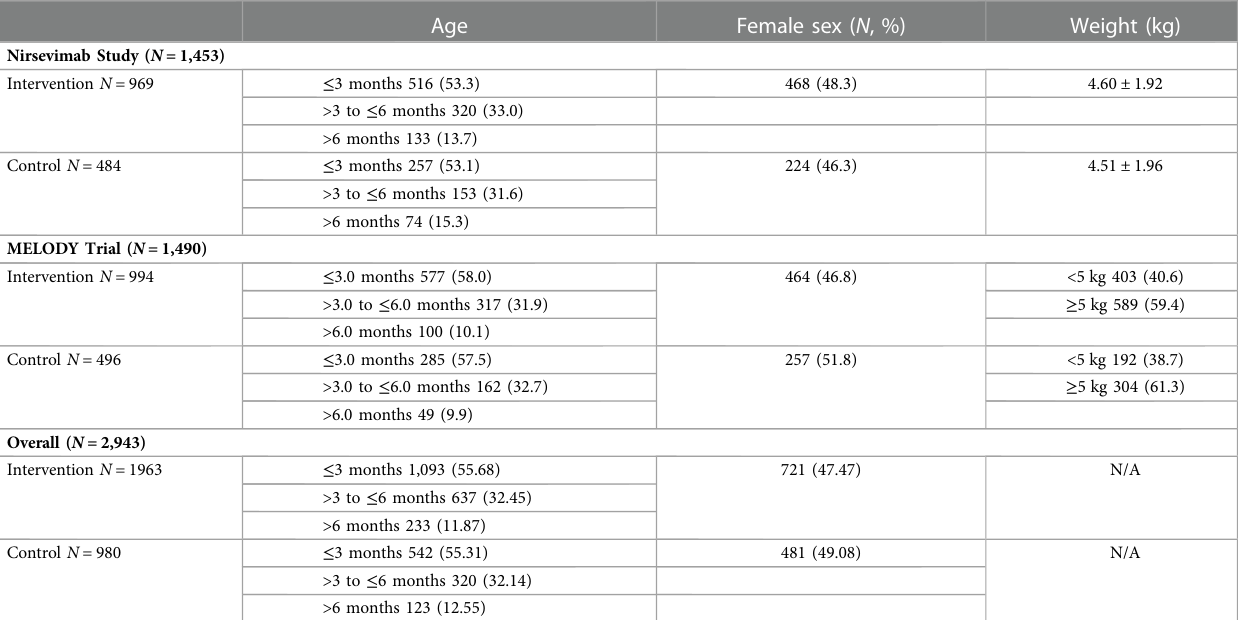
TABLE 1 Baseline